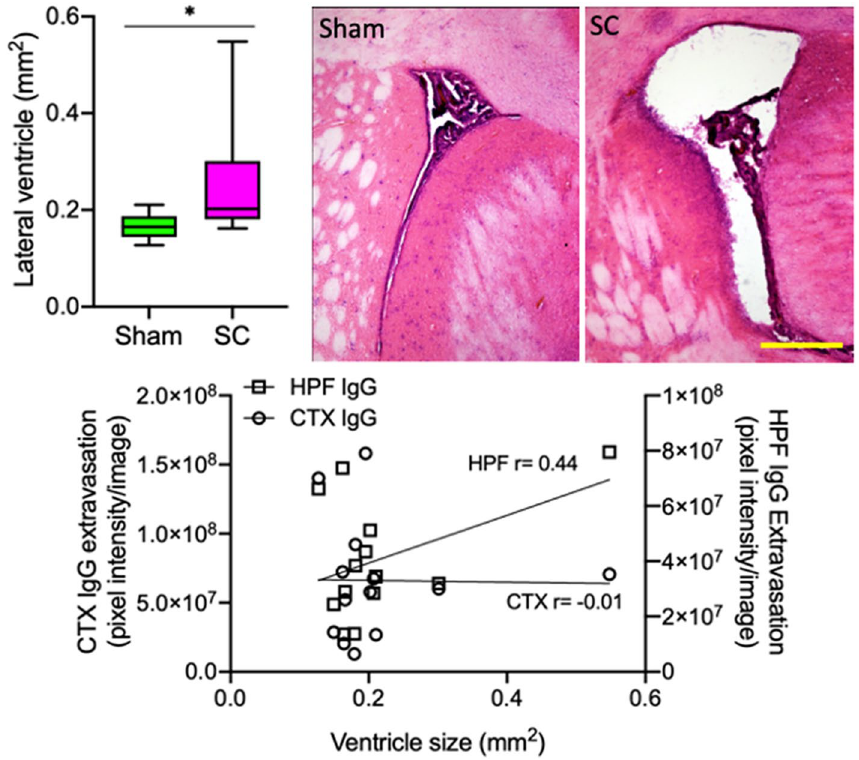
Figure 2. Lateral ventricular size. The lateral ventricle size was measured at Bregma 0 mm in sub-concussion rats (SC) (n = 6) and sham (n = 7) rats. The data is shown as the lateral ventricle area size as median ± 95% confidence interval and * indicates statistical significance at p < 0.05 assessed with Mann–Whitney test. Representative lateral ventricle microscopy images from SC and Sham rats are also presented (scale bar = 500 µm). In the lower frame, the Spearman’s correlation graph is presented to demonstrate the association between lateral ventricle size and IgG extravasation in cortex (CTX) or hippocampus